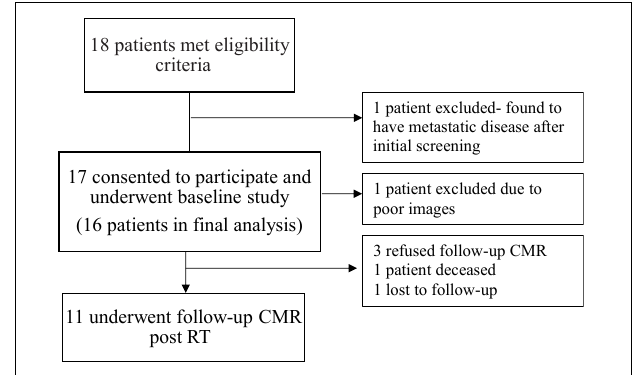
FIGURE 1 | Diagram illustrating the selection of participants for the study. CMR, cardiovascular magnetic resonance; RT, radiation therapy.